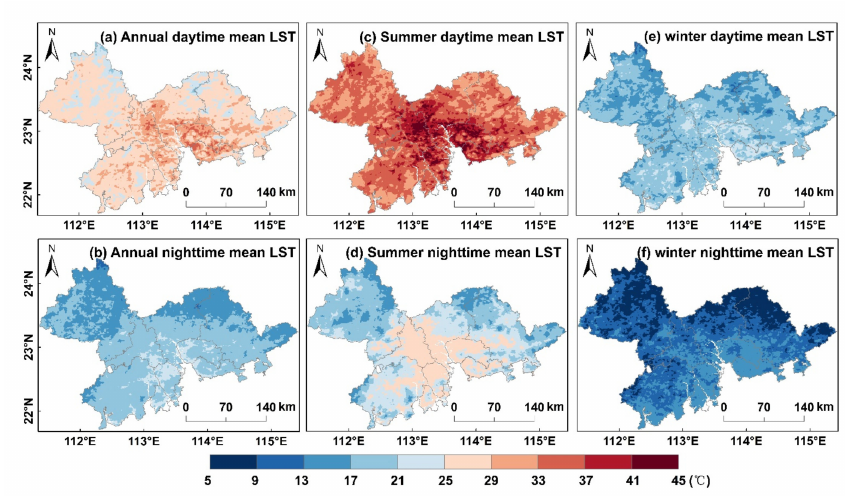
Figure 6. Spatial distribution of land surface temperature (LST) across the PRD. ( a ), ( c ) and ( e ) denote spatial distribution of annual, summer and winter daytime mean LST; ( b ), ( d ) and ( f ) denote spatial distribution of annual, summer and winter nighttime mean